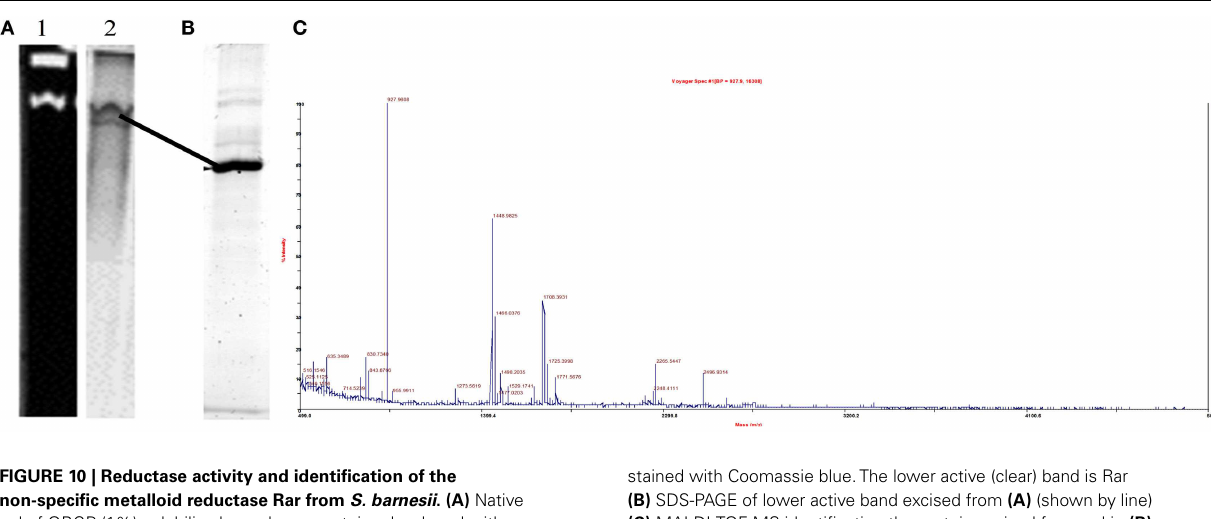
stained with Coomassie blue.The lower active (clear) band is Rar (B) SDS-PAGE of lower active band excised from (A) (shown by line) (C) MALDI-TOF MS identification the protein excised from gel in (B) as